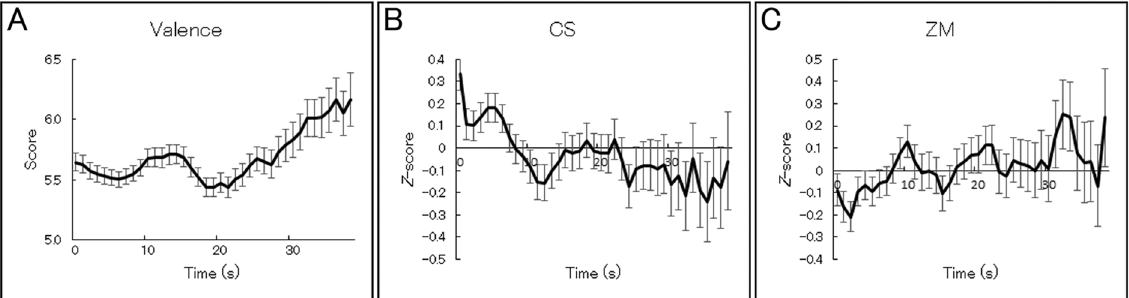
Figure 6. Grand-mean (with SE ) second-by-second continuous subjective valence ratings ( A ) and facial electromyography data recorded from the corrugator supercilii (CS) ( B ) and zygomatic major (ZM) ( C ) muscles using the wearable device in Experiment 2. The facial EMG data were standardized within individuals.